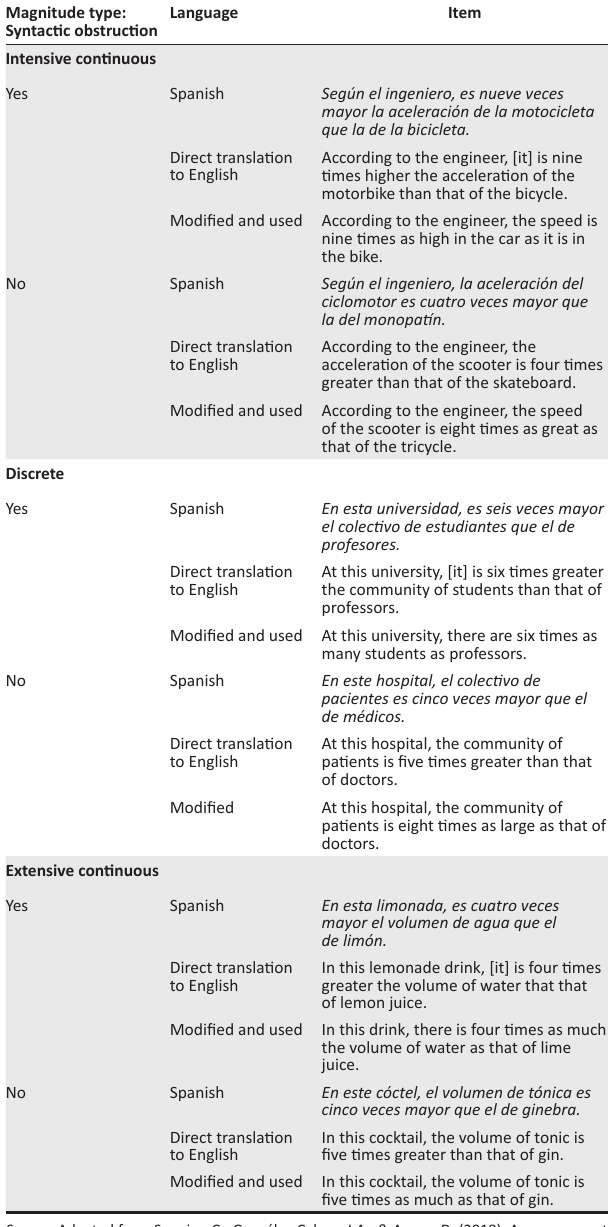
TABLE 1: Some examples of word problem statements used in Spain and South Africa. Magnitude type: Language Syntactic obstruction